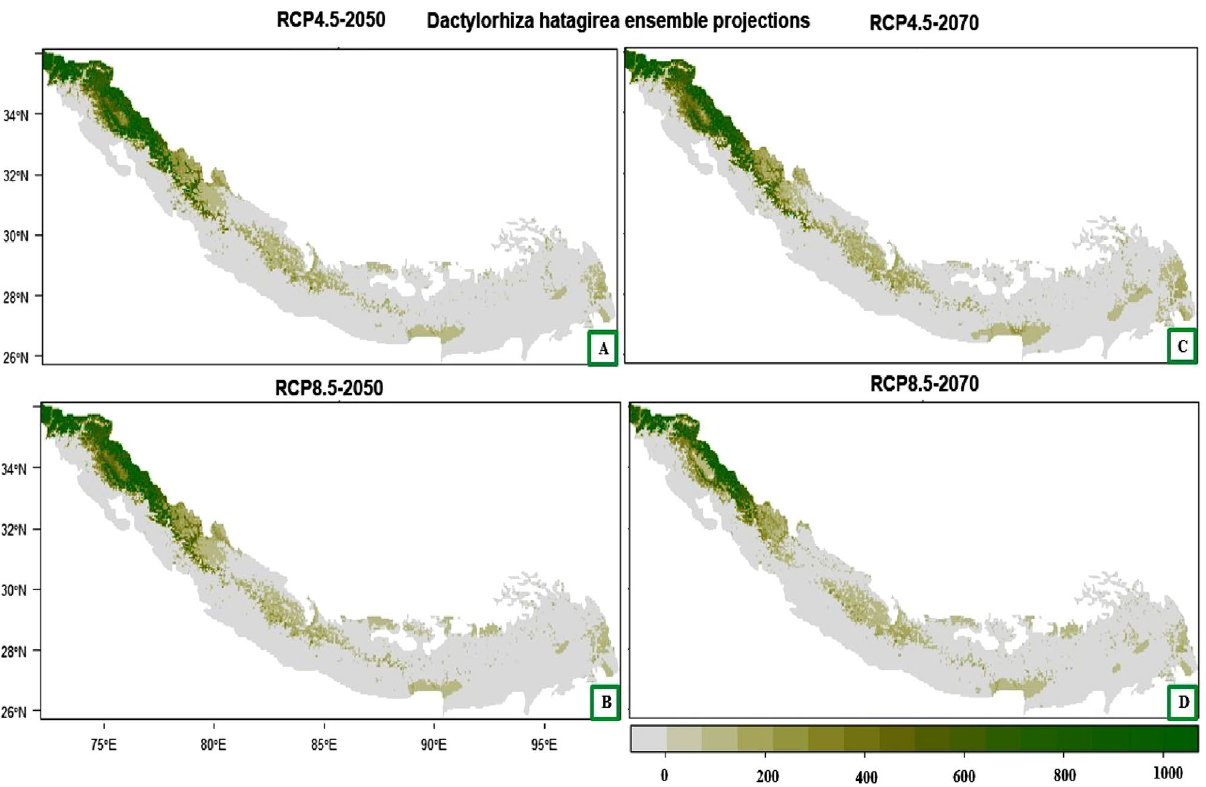
Figure 4. ( A – D ) Plot of the predicted habitat suitability for Dactylorhiza hatageria under future climate change